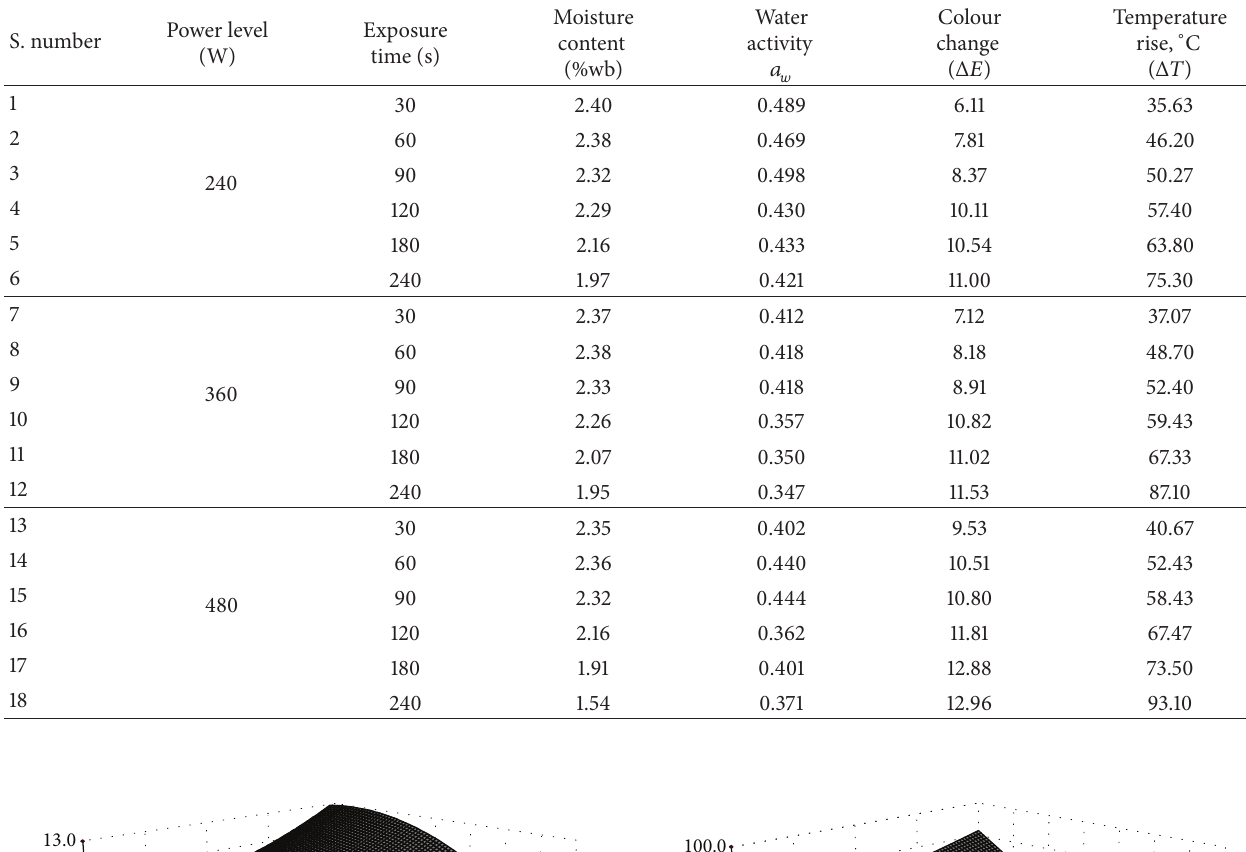
Table 2: Values of different quality parameters of microwave (MW) pretreated cashew nut. S. number